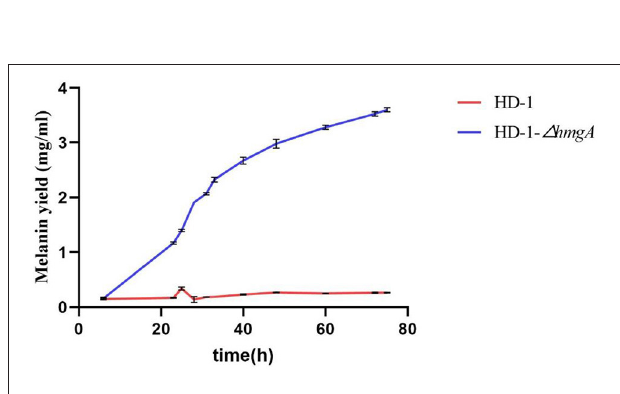
FIGURE 4 | Melanin production curves of B. thuringiensis HD-1 and HD-1- 1 hmgA in LB medium.